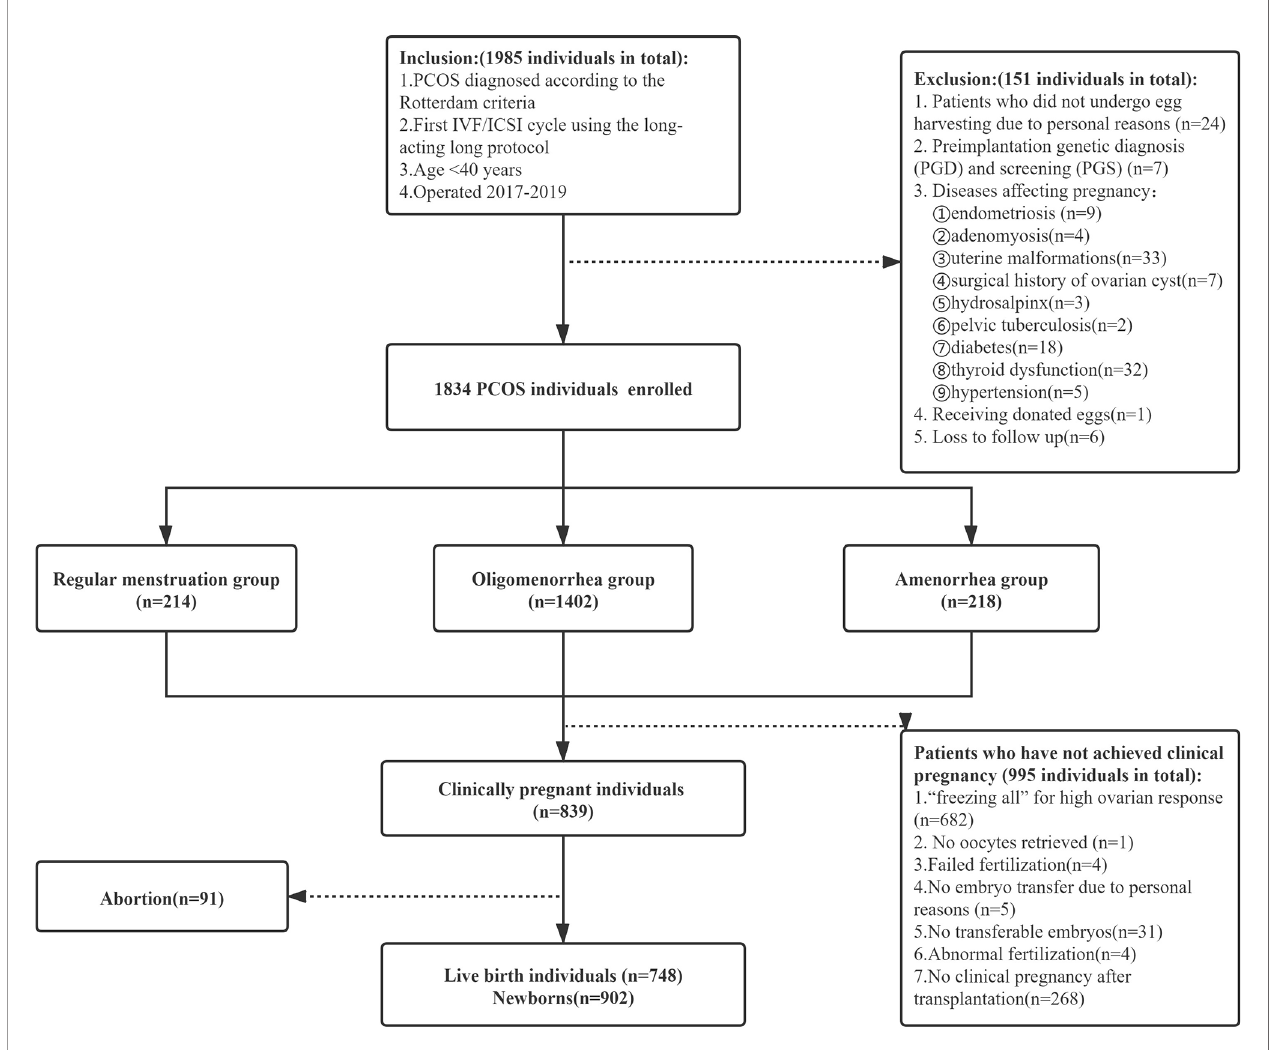
FIGURE 1 | Flow chart depicting the patient